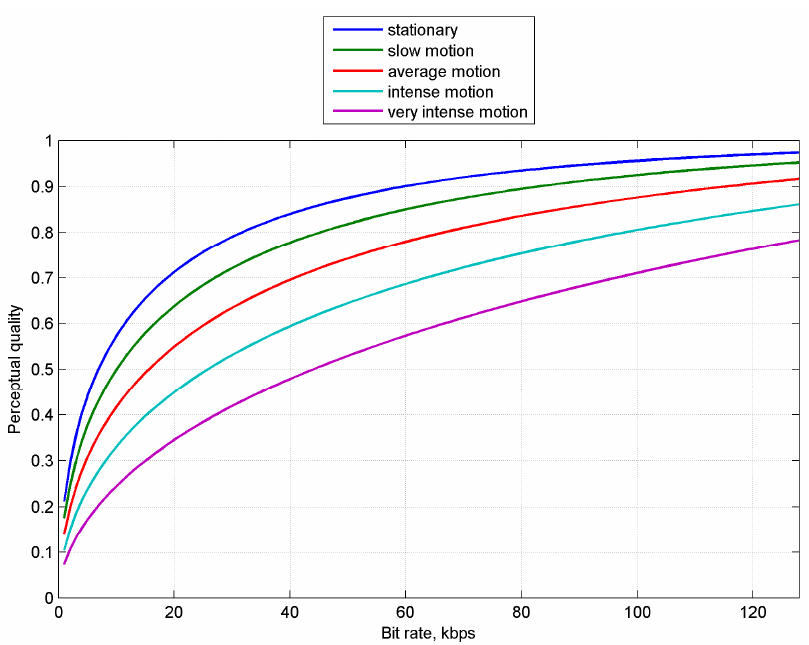
Figure 12. Evaluation of perceptual quality with different bit rates.